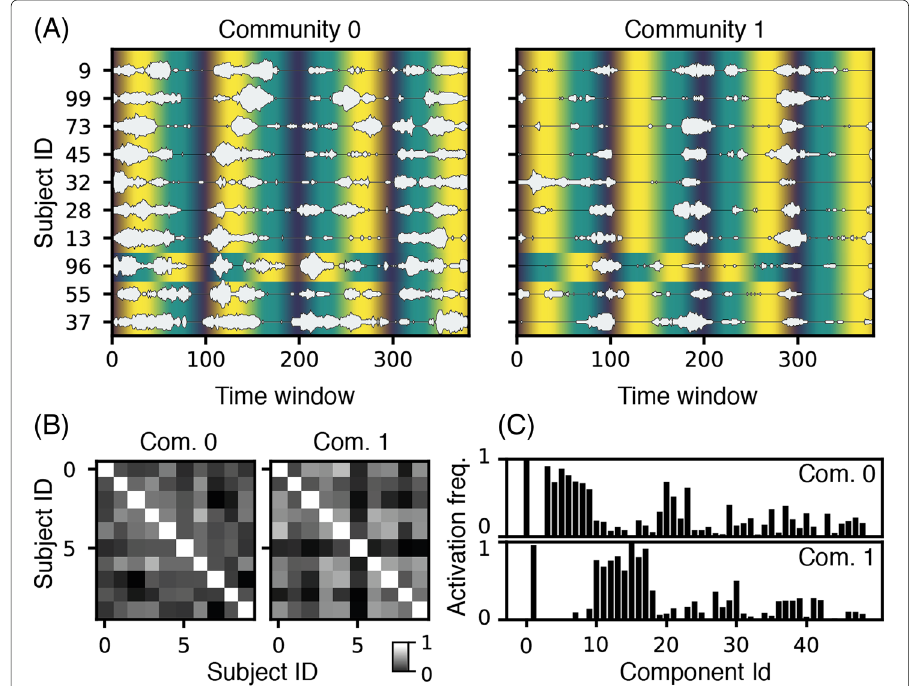
Fig. 2 Temporal communities of 10 “best” performers concatenated. a Two largest communities in the subject-concatenated network, reshaped with one subject per row to enable comparison of temporal profiles. Each row pertains to an individual subject and visualizes the temporal dynamics of the community as a white strip of varying height. The background color illustrates the task order (see Fig. 1 legend). Notice that the task order deviates for subject 96. b Inter-subject correlation of temporal activity for the two largest communities. Mean correlations (not including diagonal of ones) are 0.33 and 0.41 respectively. c Component distributions. See Additional file 1: Figure S1 for component brain